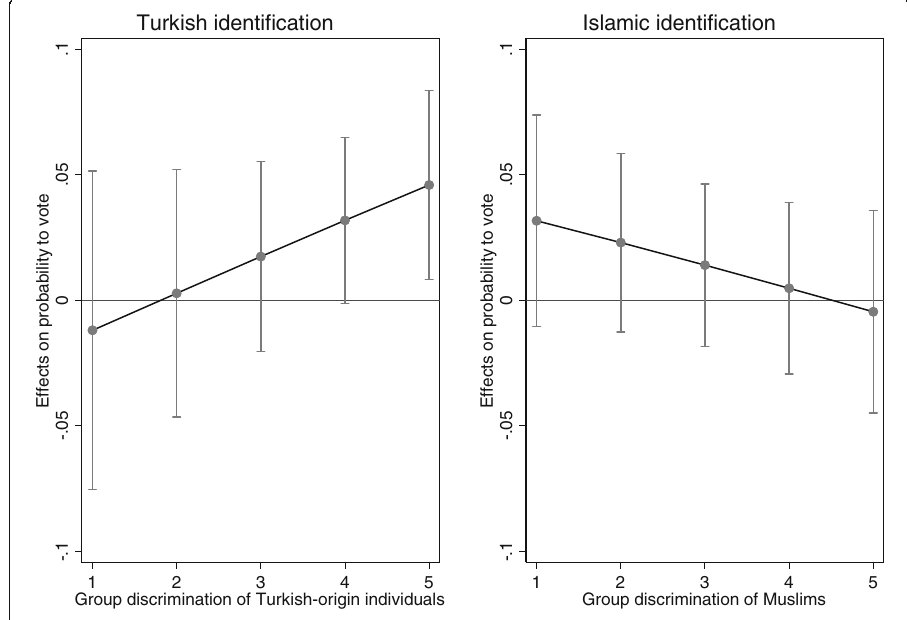
Fig. 3 Effects of Turkish and Islamic identifications on local voting according to perceptions of group discrimination (TIES surveys 2007/2008). These graphs show the marginal effects of Turkish and Islamic identification on the probability to vote locally (vertical axis) for different levels of perceived group discrimination of Turks or Muslims (horizontal axis)